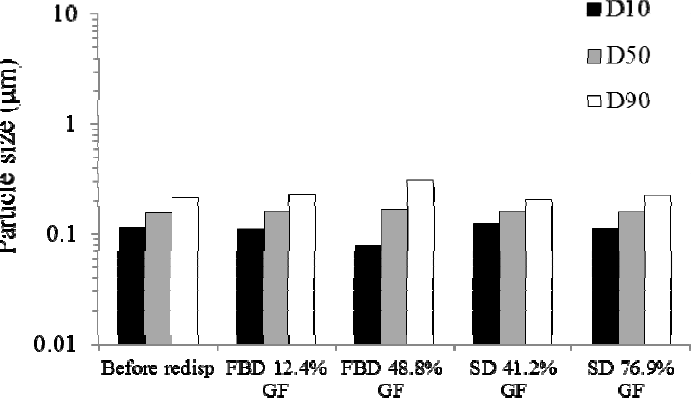
Figure 10. Impact of drug loading in the nanocomposite and drying method on redispersion of griseofulvin (GF)–HPC–SDS nanocomposite microparticles (NCMP) in water after 2 min paddle stirring at 200 rpm. FBD refers to fluid bed coating/drying of the GF nanosuspension onto Pharmatose; SD stands for spray drying. “Before redisp” particle sizes refer to the particle sizes in the wet media milled drug nanosuspension with HPC–SDS. (Adapted from Bhakay et al. [85] with permission from Elsevier, www.elsevier.com).